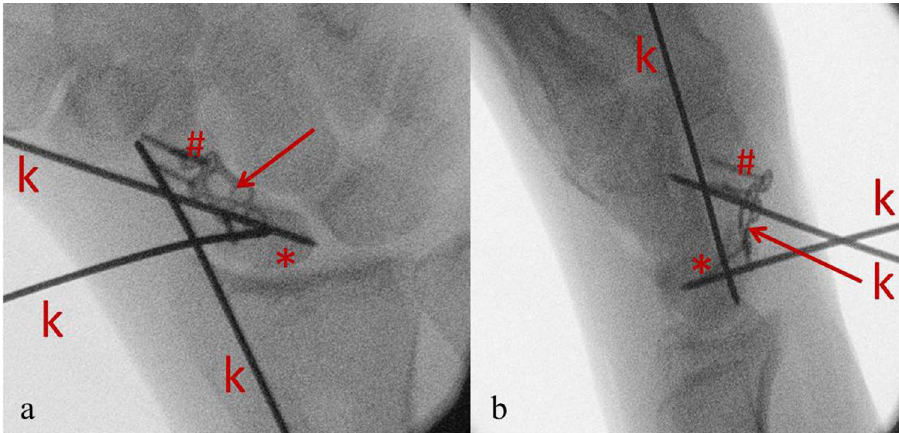
Figure 1. Intraoperative X-ray anteroposterior ( a ) and lateral ( b ) of scaphoid reposition and plate positioning. Using 2 K-wires (k) as joysticks, the proximal (*) and distal fragment (#) of the scaphoid are aligned and fixed with a third. The scaphoid plate (arrow) bridges the defect between the fragments via inserted angle-stable